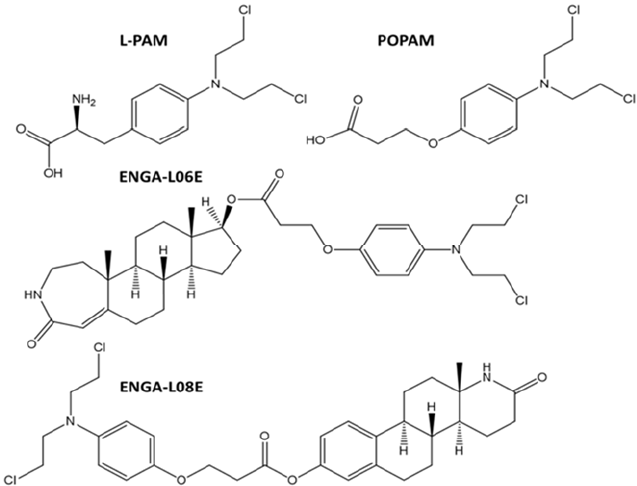
Figure 11. Chemical structures of 2-amino-3-(4-(bis (2-chloroethyl) amino) phenyl) propanoic acid (L-phenylalanine mustard, L-PAM), 3-(4-(bis(2-chloroethyl) amino) phenoxy) propanoic acid (POPAM), 5a,7a-dimethyl-2-oxo-2,3,4,5,5a,5b,6,7,7a,8,9,10,10a,10b,11,12-hexa decahydrocyclopenta [5,6] naphtho [1,2-d] azepin-8-yl 3-(4-(bis(2-chloroethyl)amino) phenoxy) propanoate (ENGA-L06E) and 12a-methyl-2-oxo-1,2,3,4,4a,4b,5,6,10b,11,12,12a-dodecahydronaphtho[2,1-f]quinolin-8-yl 3-(4-(bis (2-chloroethyl)amino) phenoxy) propanoate